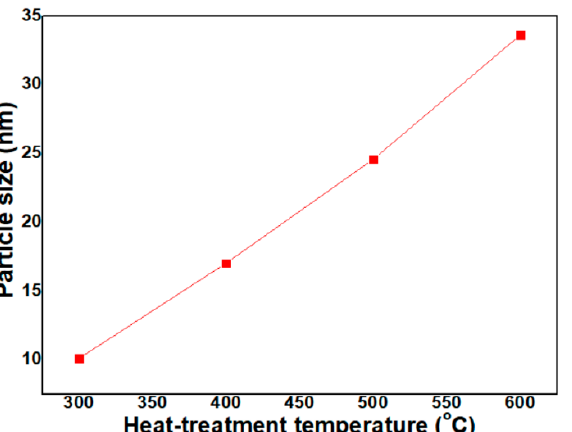
Figure 4. Variation of particle size of NiO NPs with heat-treatment temperature (calculated by using Equation (2)).